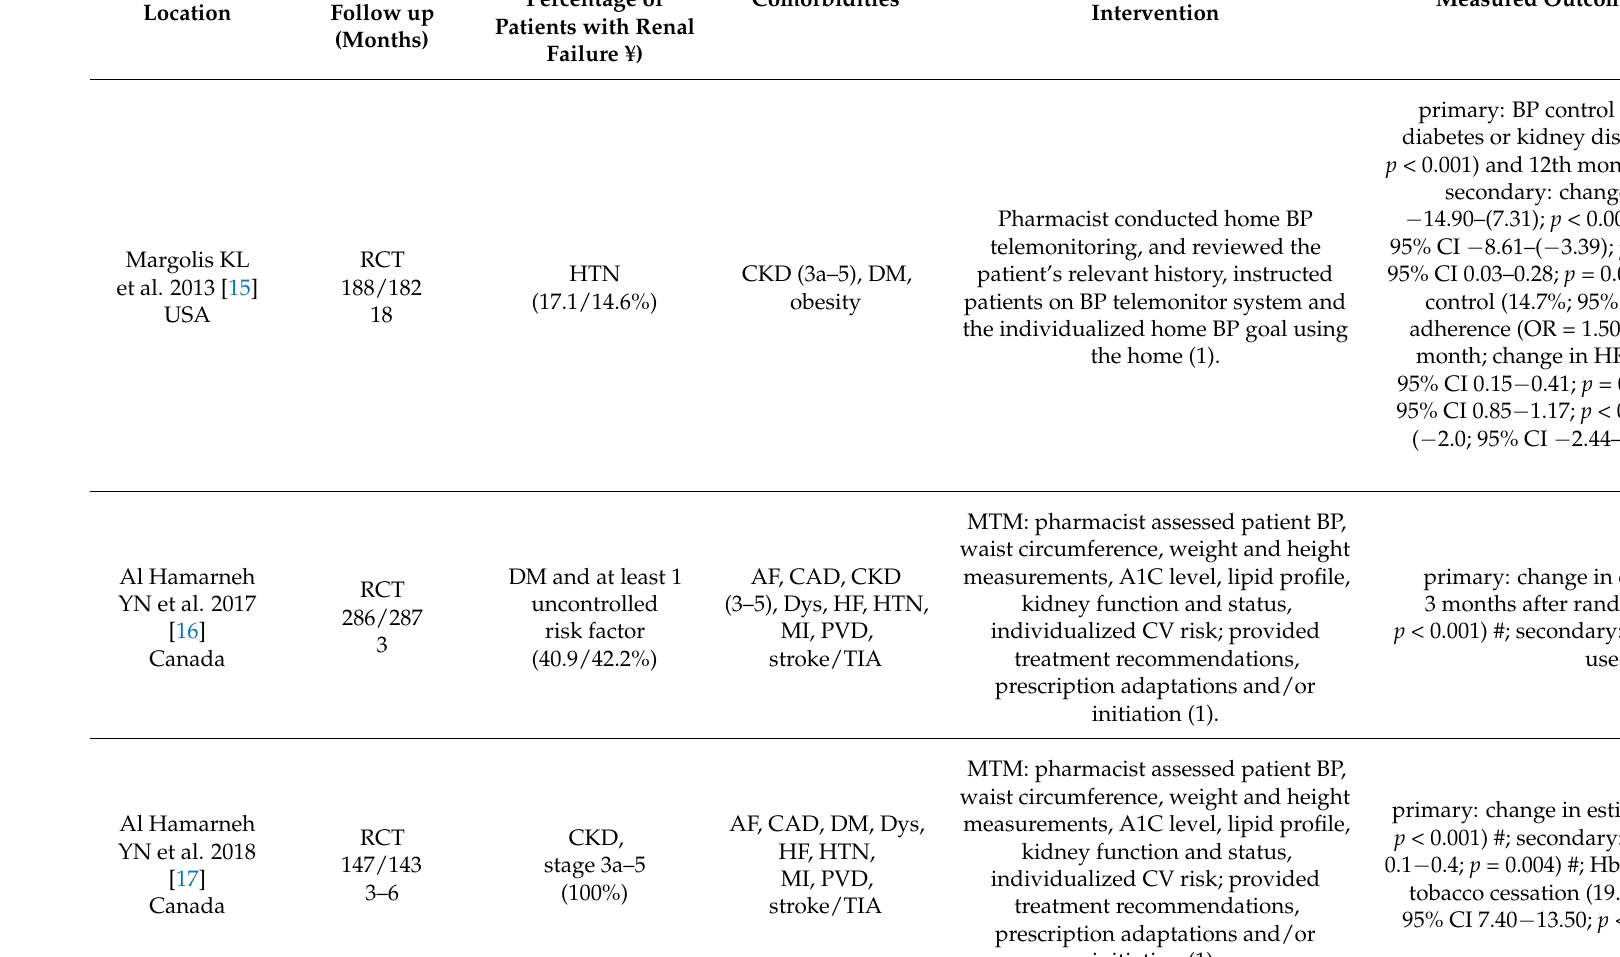
Key Components of Pharmacist Intervention